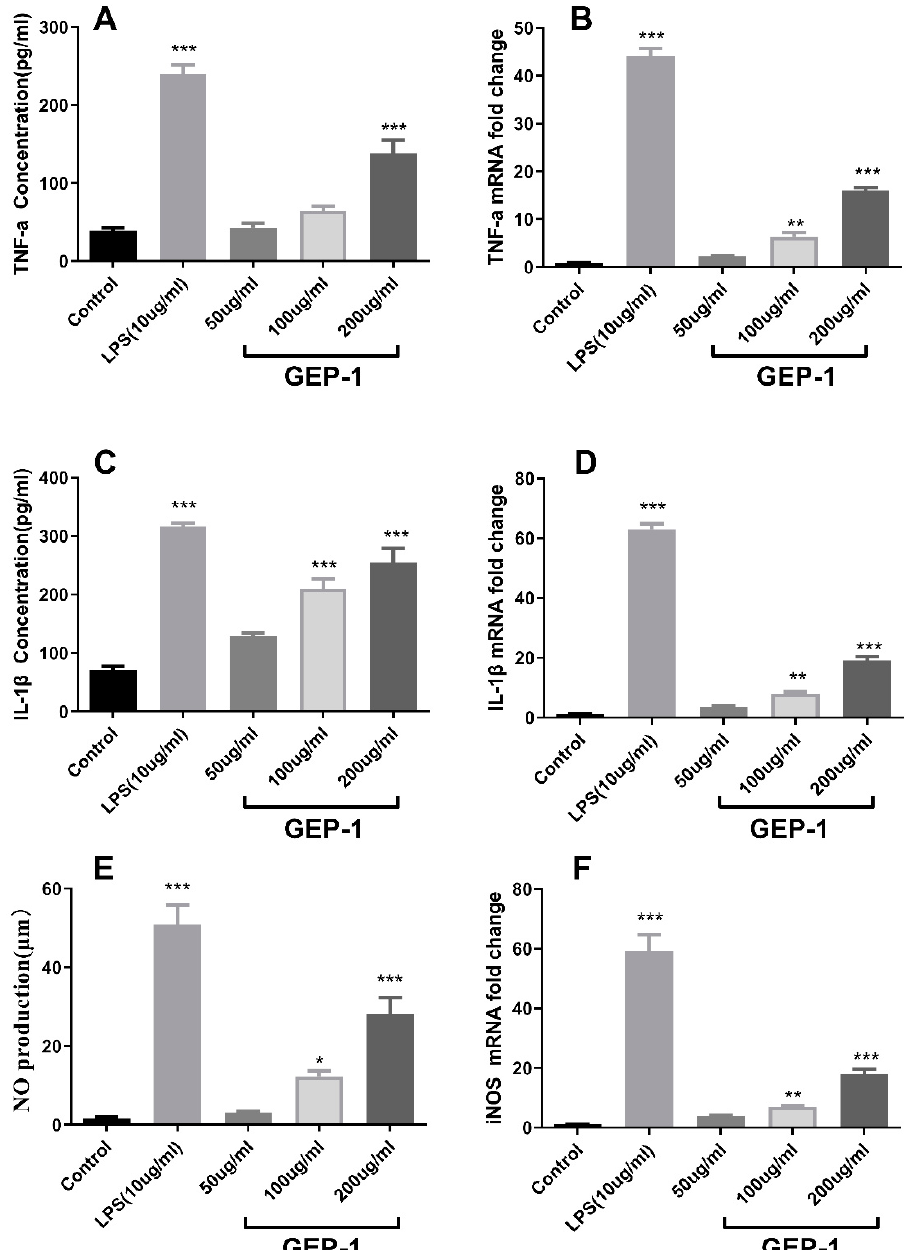
Figure 5. Effects of GEP-1 on the secretion or production of TNF- α ( A ), IL-1 β ( B ) and NO ( C ). Effects of GEP-1 on the gene expression levels of TNF- α ( D ), IL-1 β ( E ) and iNOS ( F ) * denotes the differences between the control group and other groups, * p < 0.05, ** p < 0.01, and *** p < 0.001.